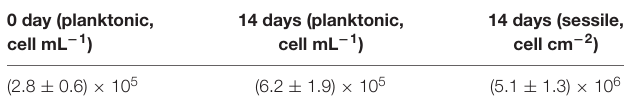
Frontiers in Microbiology |